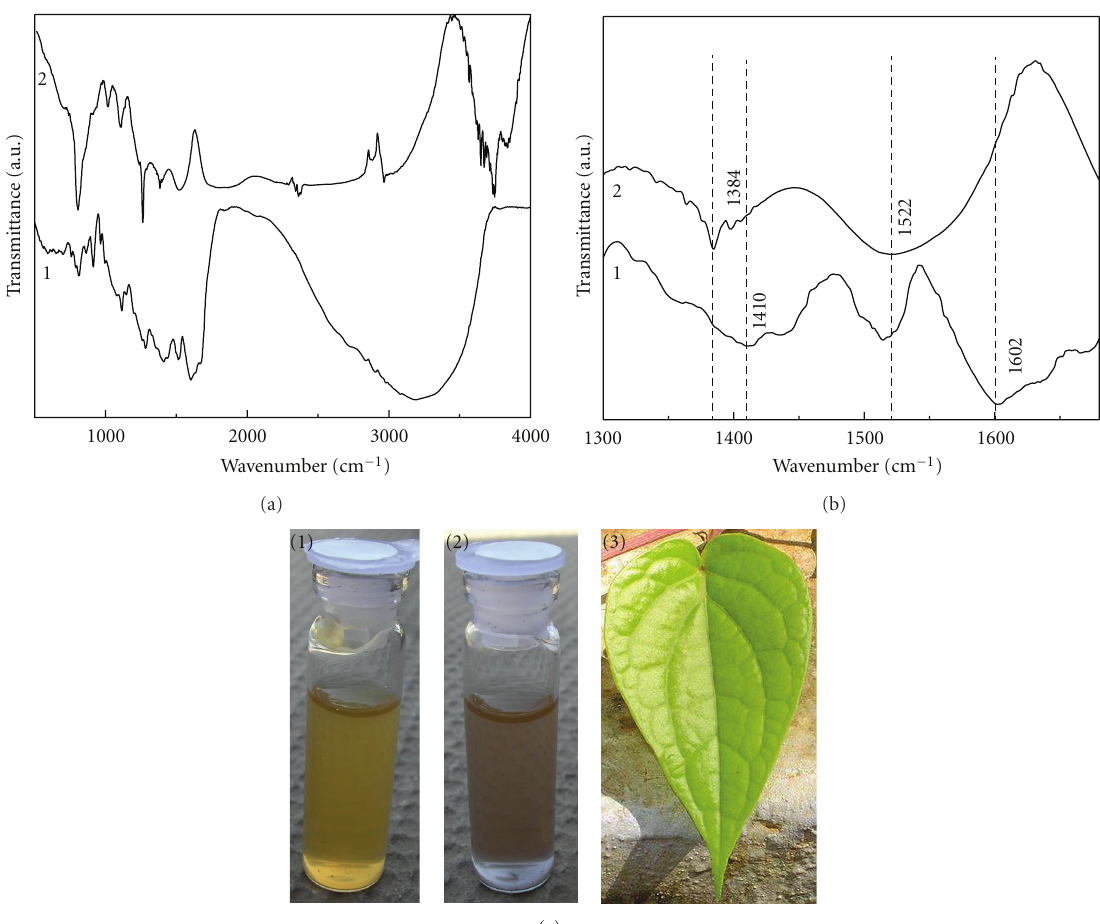
Figure 2: FTIR spectra of (1) pure Piper betle leaf broth and (2) Piper betle leaf-reduced gold nanoparticles in the wavenumbers range from (a) 400 to 4000 cm − 1 and (b) 1300 to 1750 cm − 1 ; (c) it shows aqueous extract of Piper betle leaf (1), Piper betle leaf-reduced gold nanoparticles (2), and Piper betle leaf